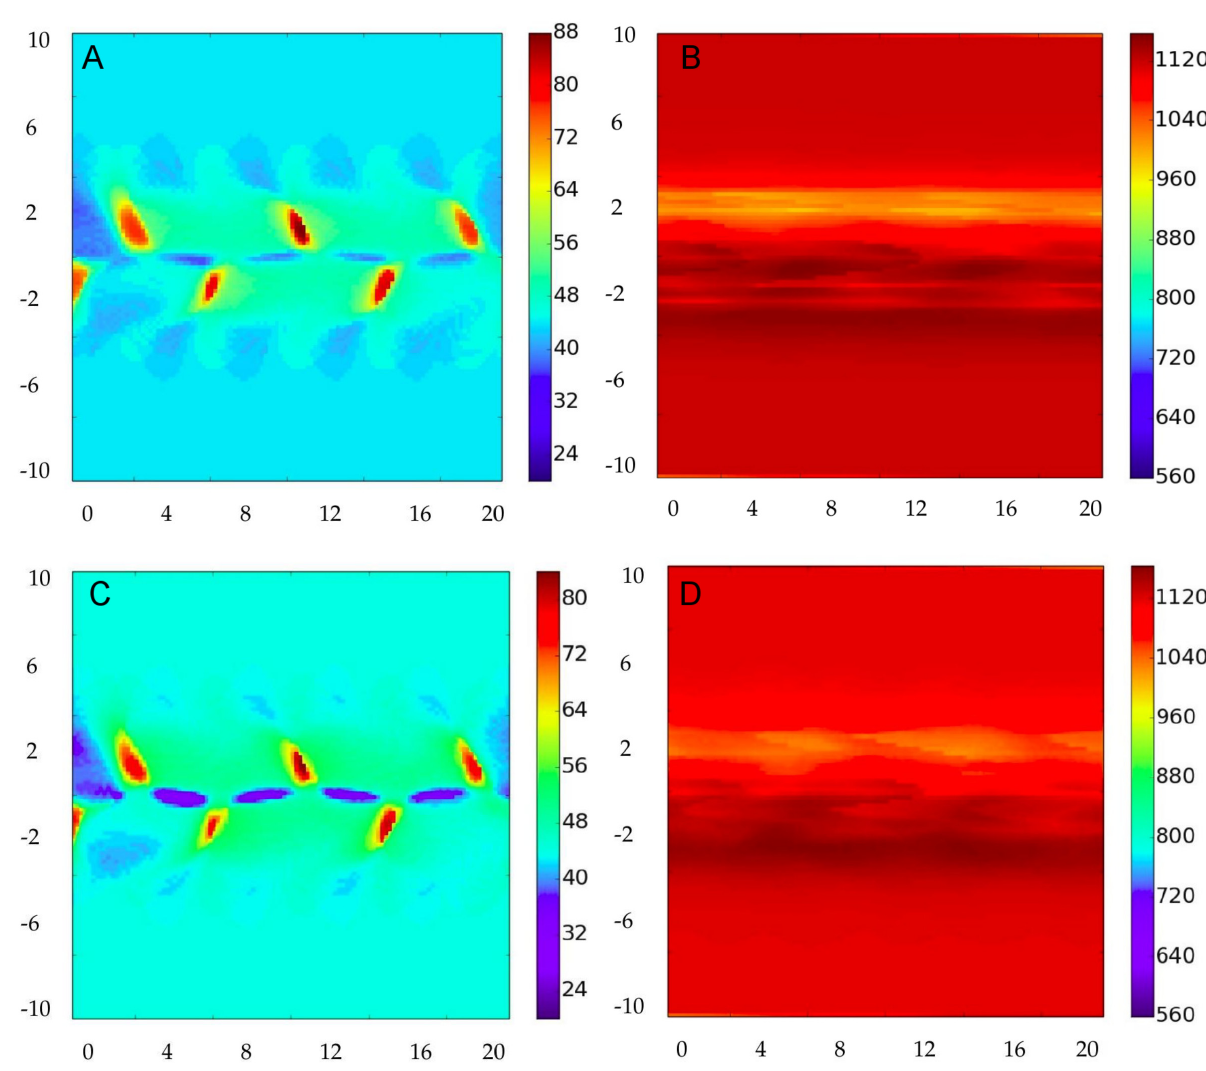
Fig 2. Node degree centrality for the correlation networks constructed for different flows and decay rates. The direction x is horizontal and y is the vertical. Panels A and B display the case of the static flow, ν = 0. C and D are for the amplitude-changing case, ν = 0.7. The network for the dynamic case is plotted at a time after t = 0 multiple of the flow period. Then, for all panels the streamfunction at the time plotted is the one shown in Fig 1. Panels A and C are for the fast decay case b = 1, and B and D are for the slow decay, b = 0.05, of the transported substance. Other parameters as stated in the